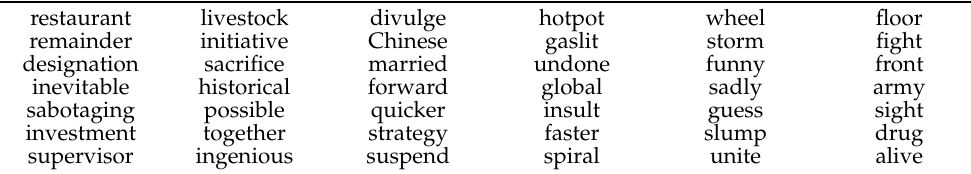
Table 3. Cluster of “Chinavirus”, 1–15 March 2020.